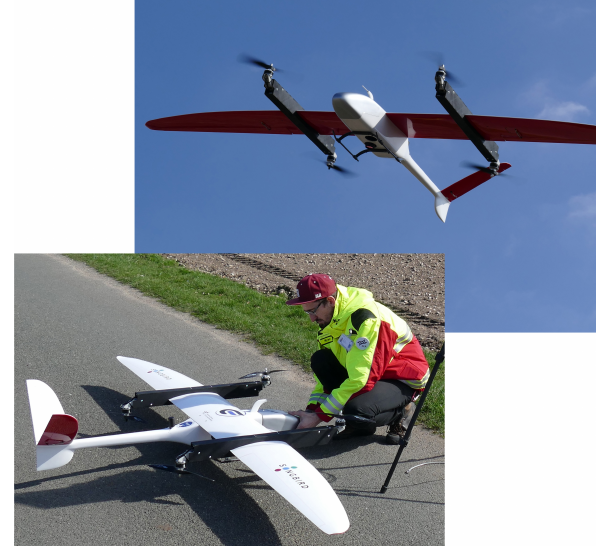
Figure 5. VTOL-UAV Songbird by Germandrones with DLR MACS UAV aerial camera